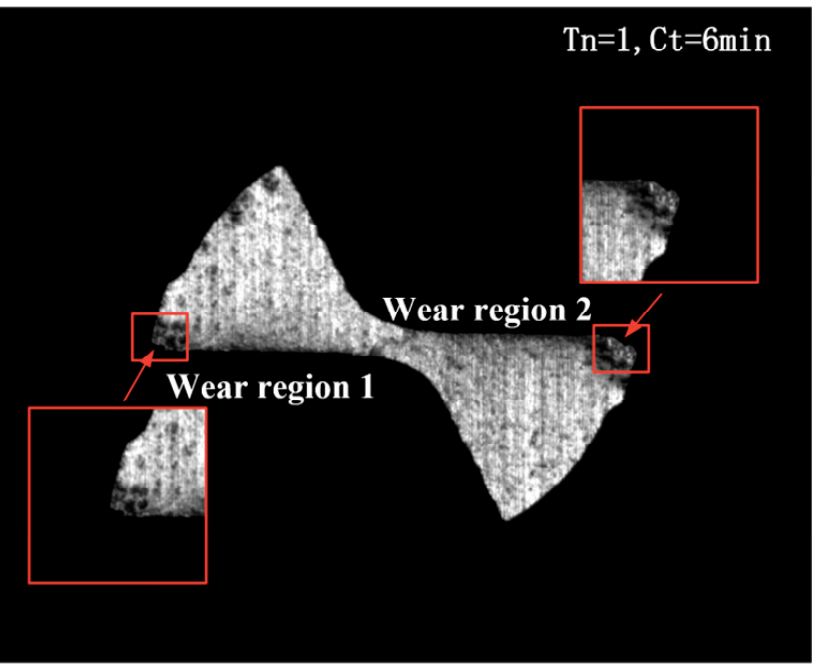
Figure 6. Template image developed for image processing algorithm of tool wear in situ monitoring of micro end milling tool cutter.